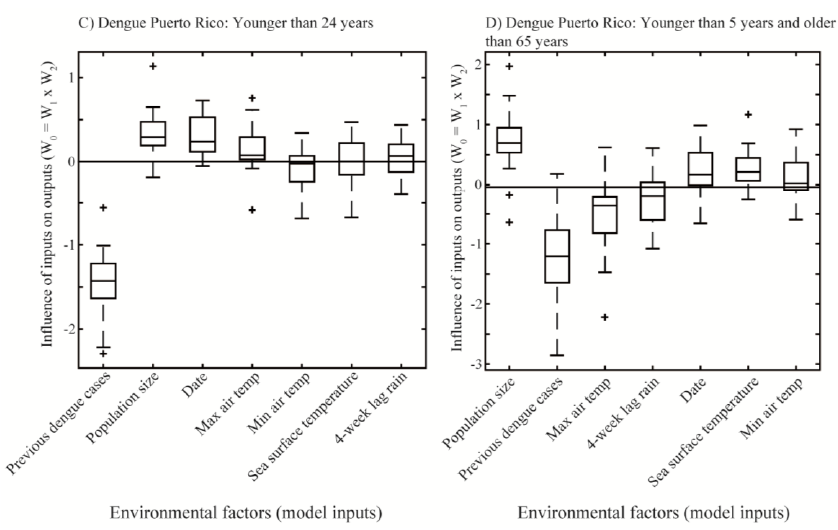
Figure 5. Distribution of environmental factors weights in the ANNs to predict dengue fever outbreak occurrences in Mexico and Puerto Rico. The box and whiskers plots show the influence of each environmental factor on dengue fever outbreak occurrences predictions based on weights distributions (W 0 ) calculated by the ANNs’ models. Boxes show the distribution of weights, lines inside the boxes are the mean values of weights. Zero lines represent no relevance for predicting dengue fever outbreak occurrences. These weights are shown in order of importance for: ( A ) population younger than 24 years, Mexico; ( B ) population younger than five years and older than 65 years, Mexico; ( C ) population younger than 24 years, Puerto Rico; and ( D ) population younger than five years and older than 65 years, Puerto Rico.